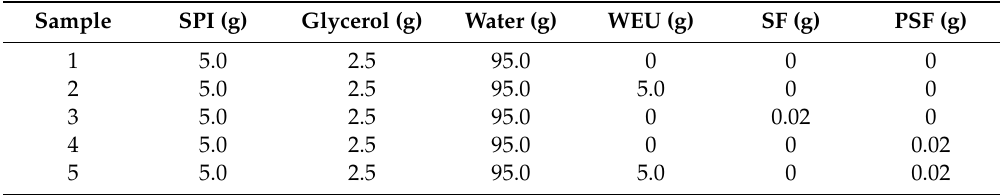
Table 2. Experimental details and summary of the various soy protein isolate (SPI)-based films